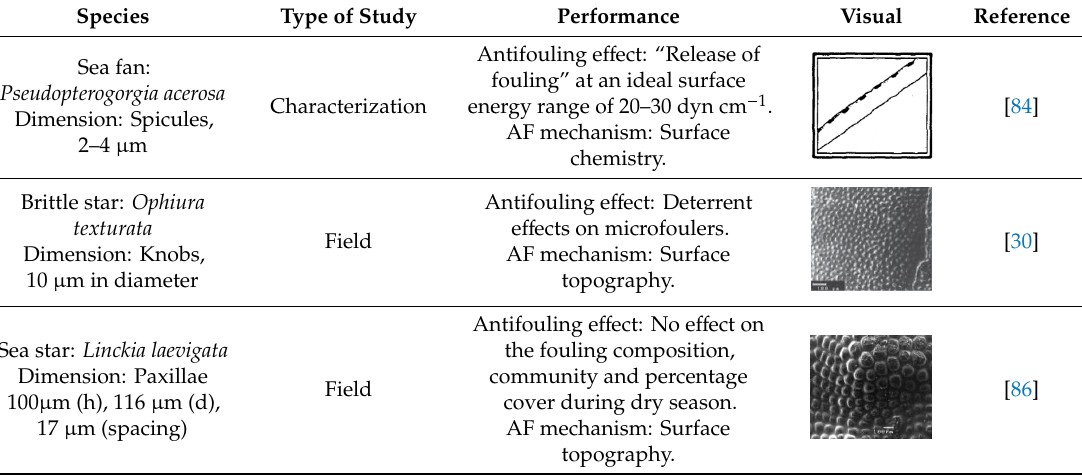
Table 4. Summary of bioinspired micro-topographies reported from marine organisms in this review.